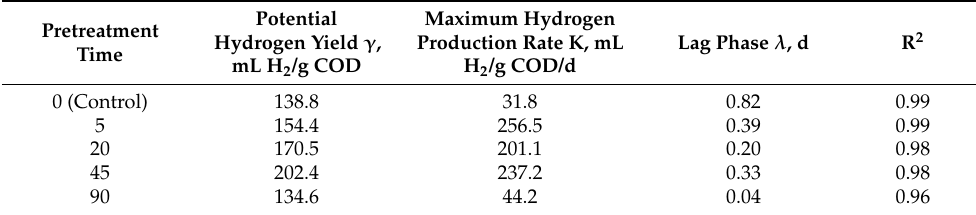
Table 3. Kinetic parameters of biohydrogen production.